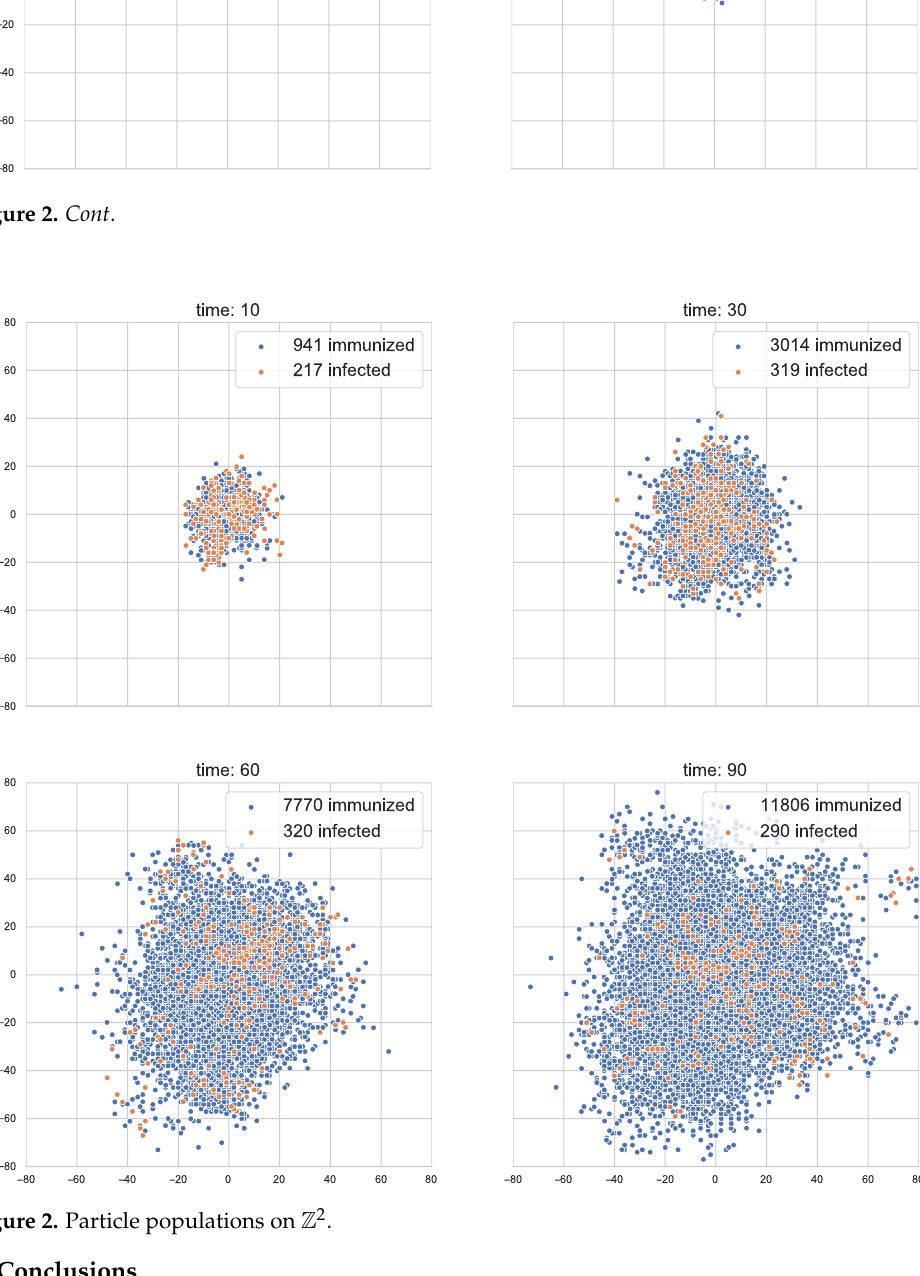
Figure 2. Particle populations on Z 2